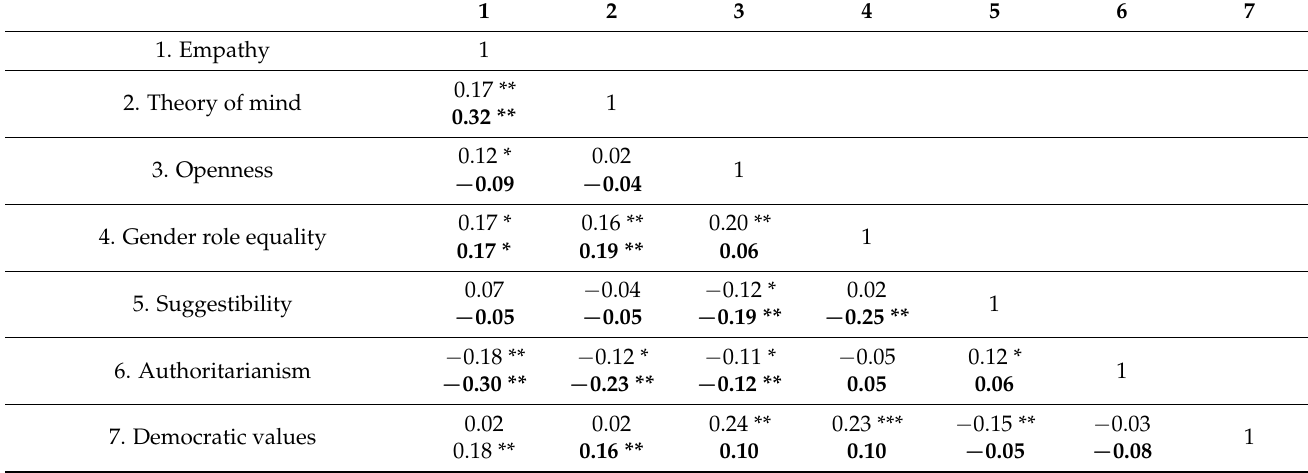
Table 4. Intercorrelations of variables in Dari and Pashtospeaker ( in bold )